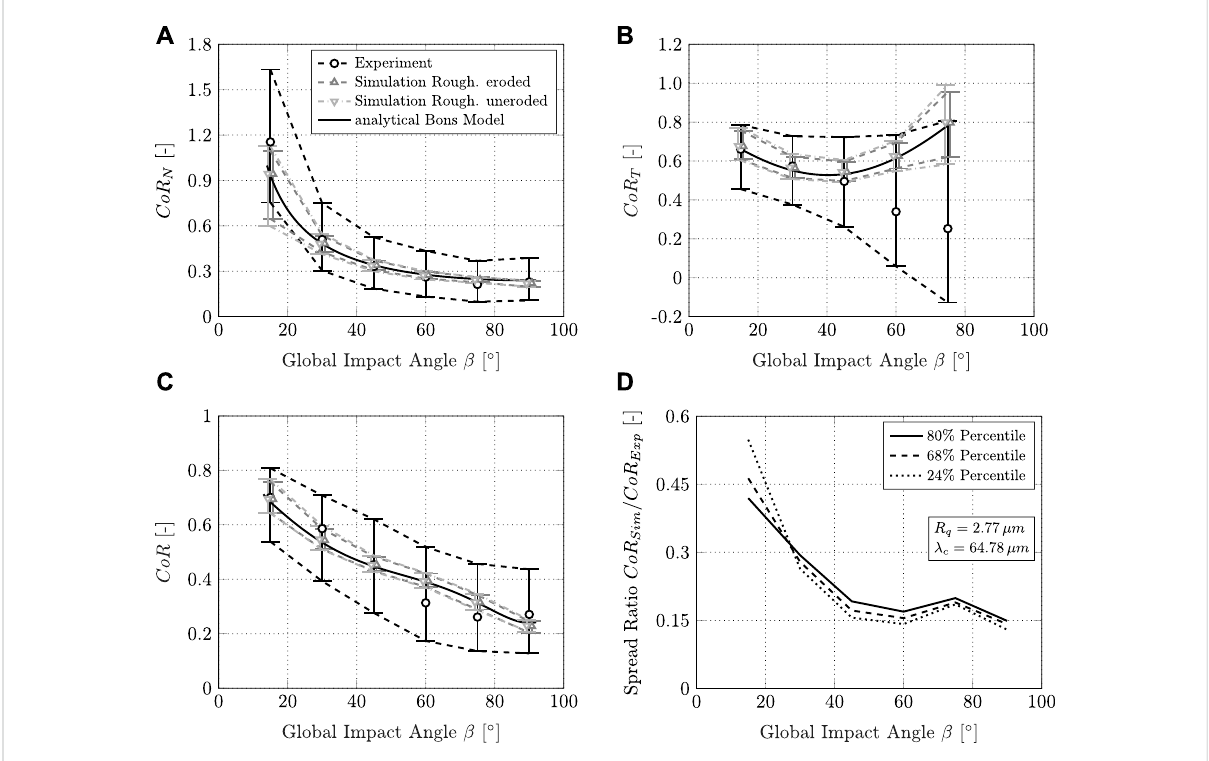
FIGURE 12 Experimental and numerical data: (A) CoR N , (B) CoR T , and (C) CoR over the global impact angle (including 68% percentile) using the PSV post- processing routine; (D) ratio of CoR spread range measured in the experiment and spread obtained in the numerical simulation while applying the spread model for the uneroded roughness ( R q (cid:1) 2 . 77 μ m , λ c (cid:1) 64 . 78 μ m ) .